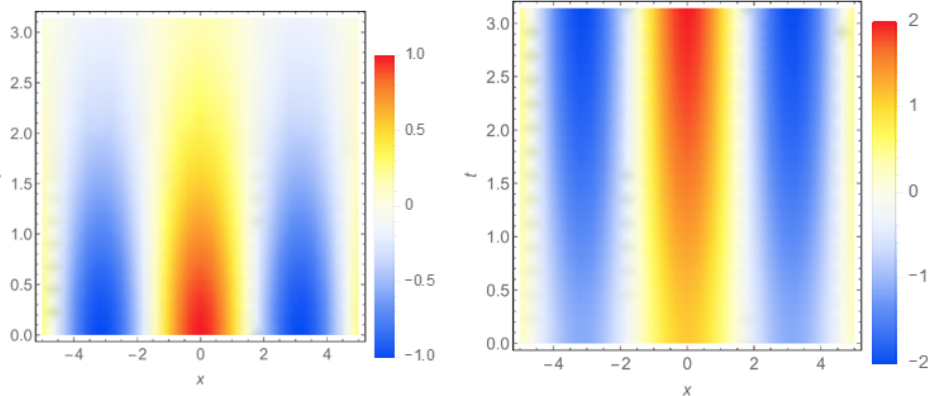
Figure 5. Evolution of quasi-temperature components in a stationary thin film with Kn b = Kn d = 0.1 for v = 0: θ b ( x , t ) —left plot, θ d ( x , t ) —right plot. The Cauchy conditions for PDEs (9) and (10) system are θ b ( x ,0 ) = θ d ( x ,0 ) = e inx , ∂ t θ b ( x ,0 ) = ∂ t θ d ( x ,0 ) = .